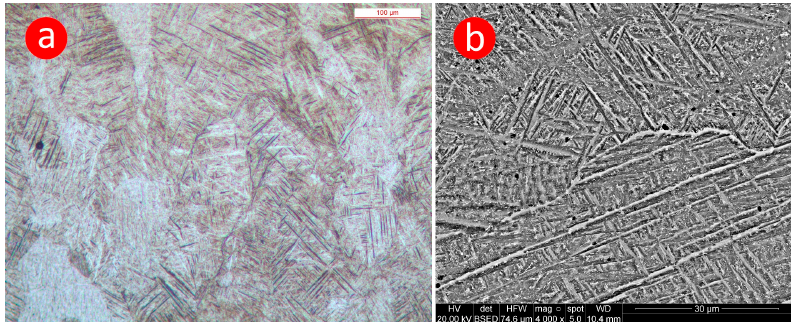
Figure 5. Optical Microscope ( a ) and Environmental Scanning Electron Microscope ( b ) micrographs of the analyzed material.